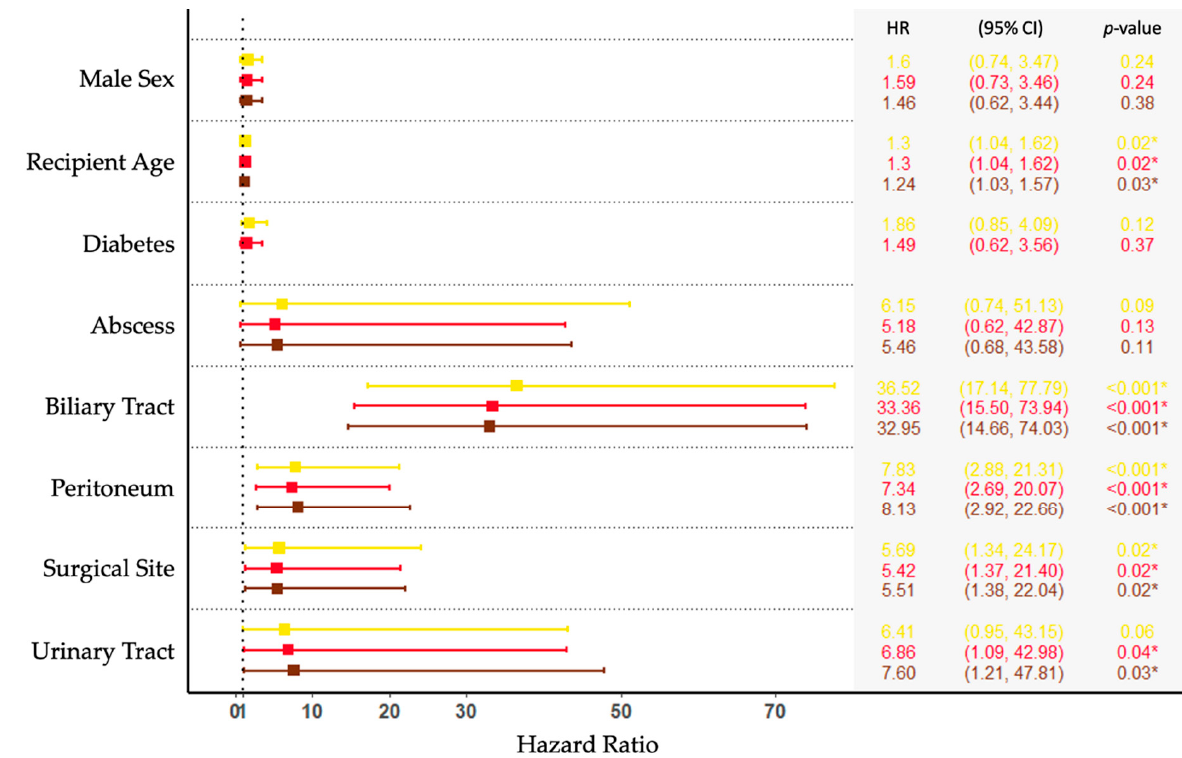
Figure 3. Time-updated Cox hazard functions of site of focal enterococcal infection. Forest plots represent the unadjusted (yellow), adjusted for age and sex (red), and adjusted for age, sex, and diabetes (brown) models. Note: One person may experience several bloodstream infections. All sites were time-updated variables contributing to the risk of enterococcal bloodstream infection 3 days before to 14 days after the focal enterococcal infection. The asterisk (*) represents p <